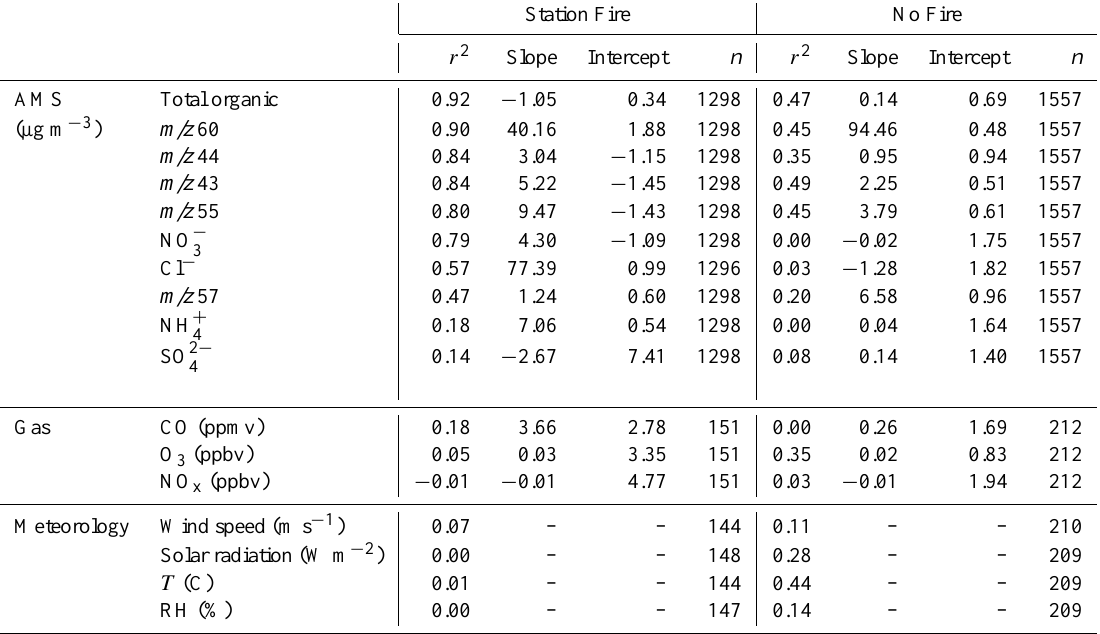
Table 1. Summary of the statistical relationships between WSOC (µgCm − 3 ) and other chemical and meteorological parameters (meteoro- logical data from the Santa Fe Dam